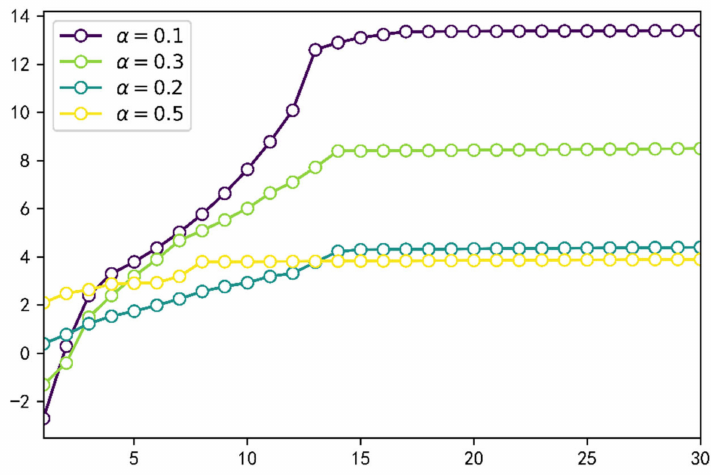
Figure 8. The peak variable of the elastic perturbation area